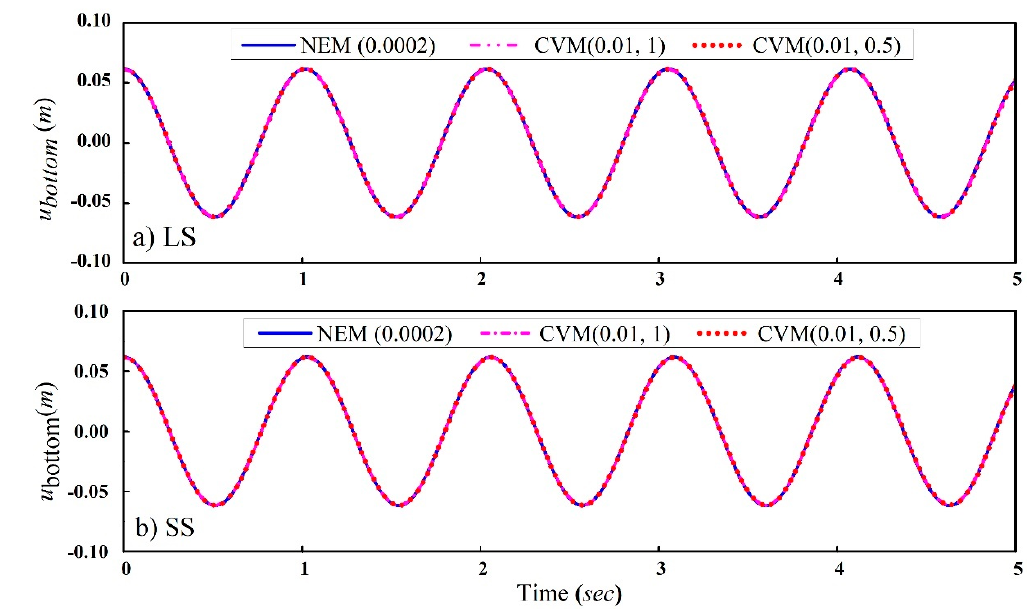
Figure 13. Eight-storey shear beam building.